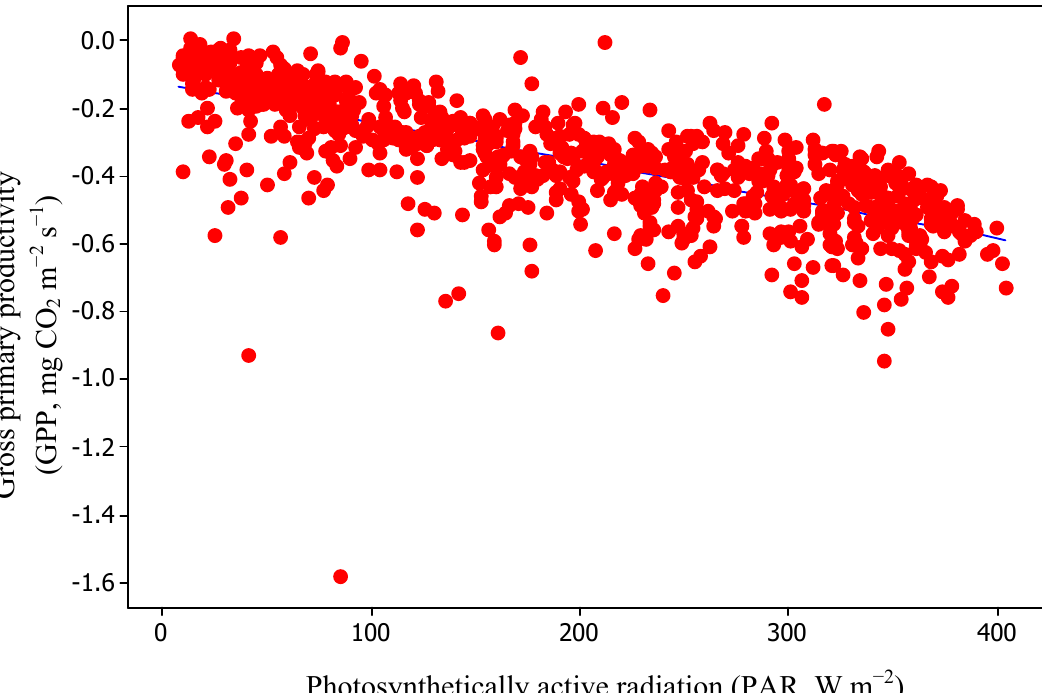
Figure 15. Quantification of relationship between PAR and GPP based on Equation (11) for the Yenicaga peatland ( R 2 = 55.0%; SE = 0.1182; n = 896; P < adj